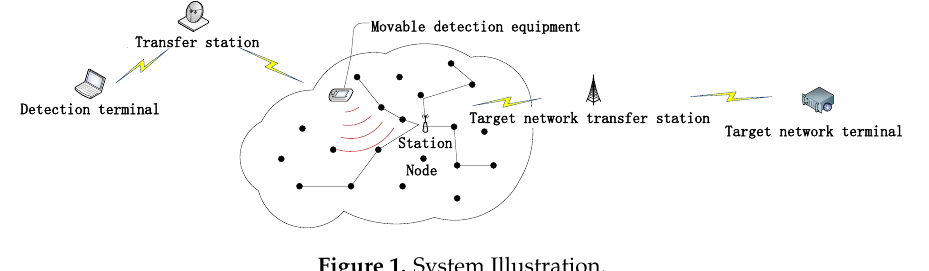
Figure 1. System